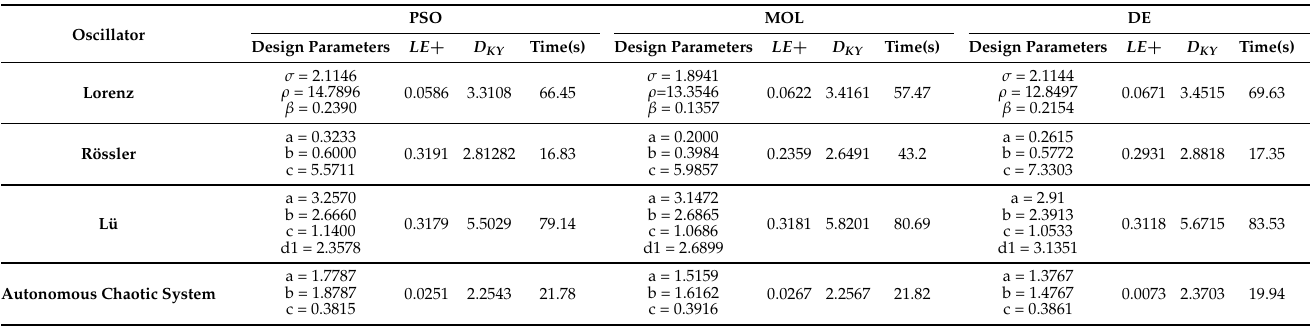
Table 6. Results performed by PSO, MOL and DE for the four chaotic oscillators. Time(s) includes the time of the numerical method and TISEAN.